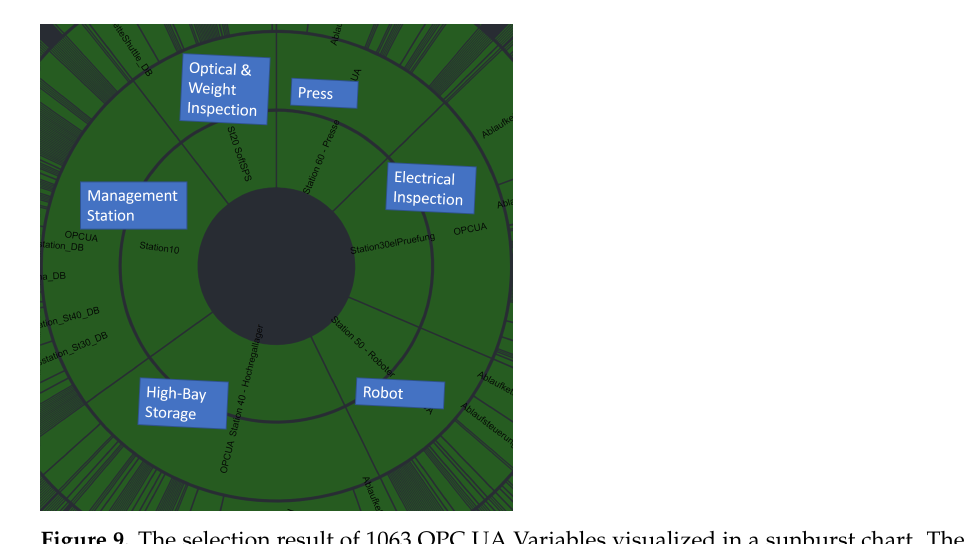
Figure 9. The selection result of 1063 OPC UA Variables visualized in a sunburst chart. The more variables that exist in a subtree, the larger the